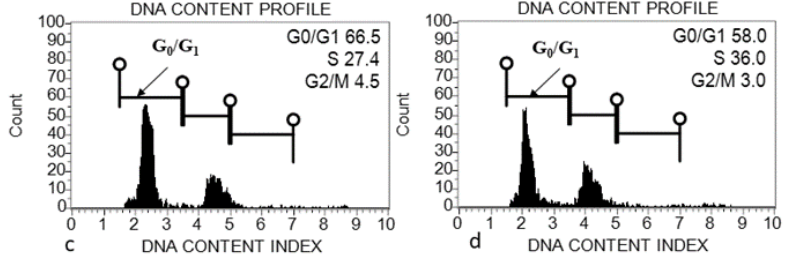
Figure 2. Flow cytometry (FCM) histograms of propidium iodide (PI) fluorescence intensity of nuclei prepared from cotyledon of Acacia etbaica using different extraction buffers. ( a ) Galbraith’s buffer; ( b ) MB01 Buffer; ( c ) Tris-MgCl2 buffer; ( d ) LB01 buffer.